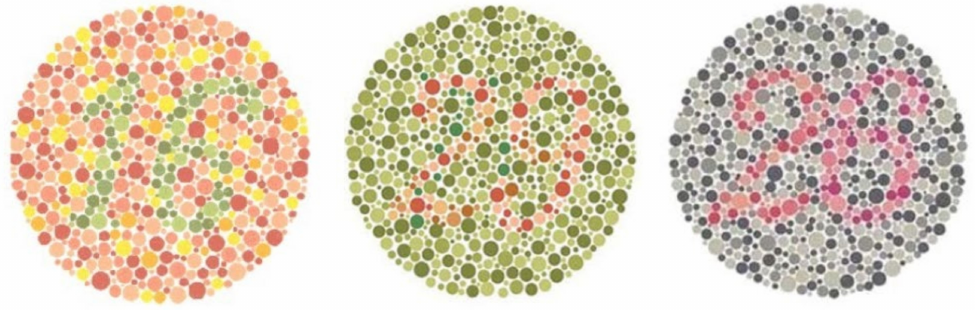
Figure 5. The cards used in the questionnaire for the color blindness test